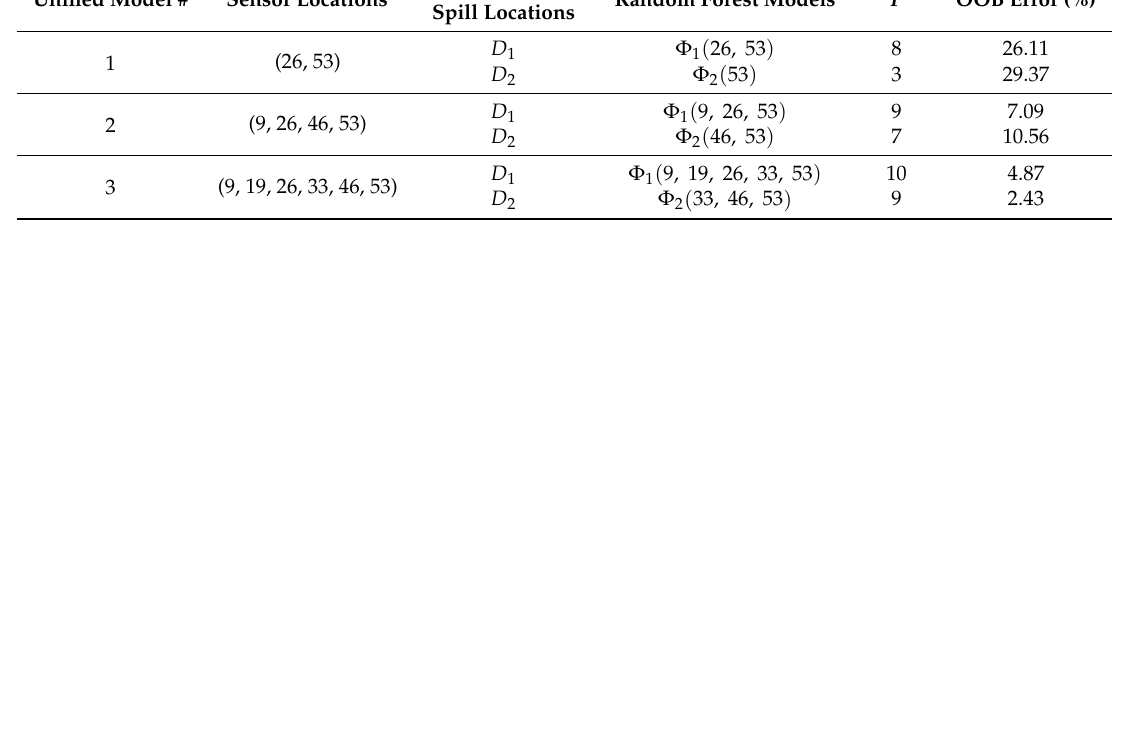
Table 1. Details of unified classification models with parameters and out-of-bag (OOB) errors. Unified Model